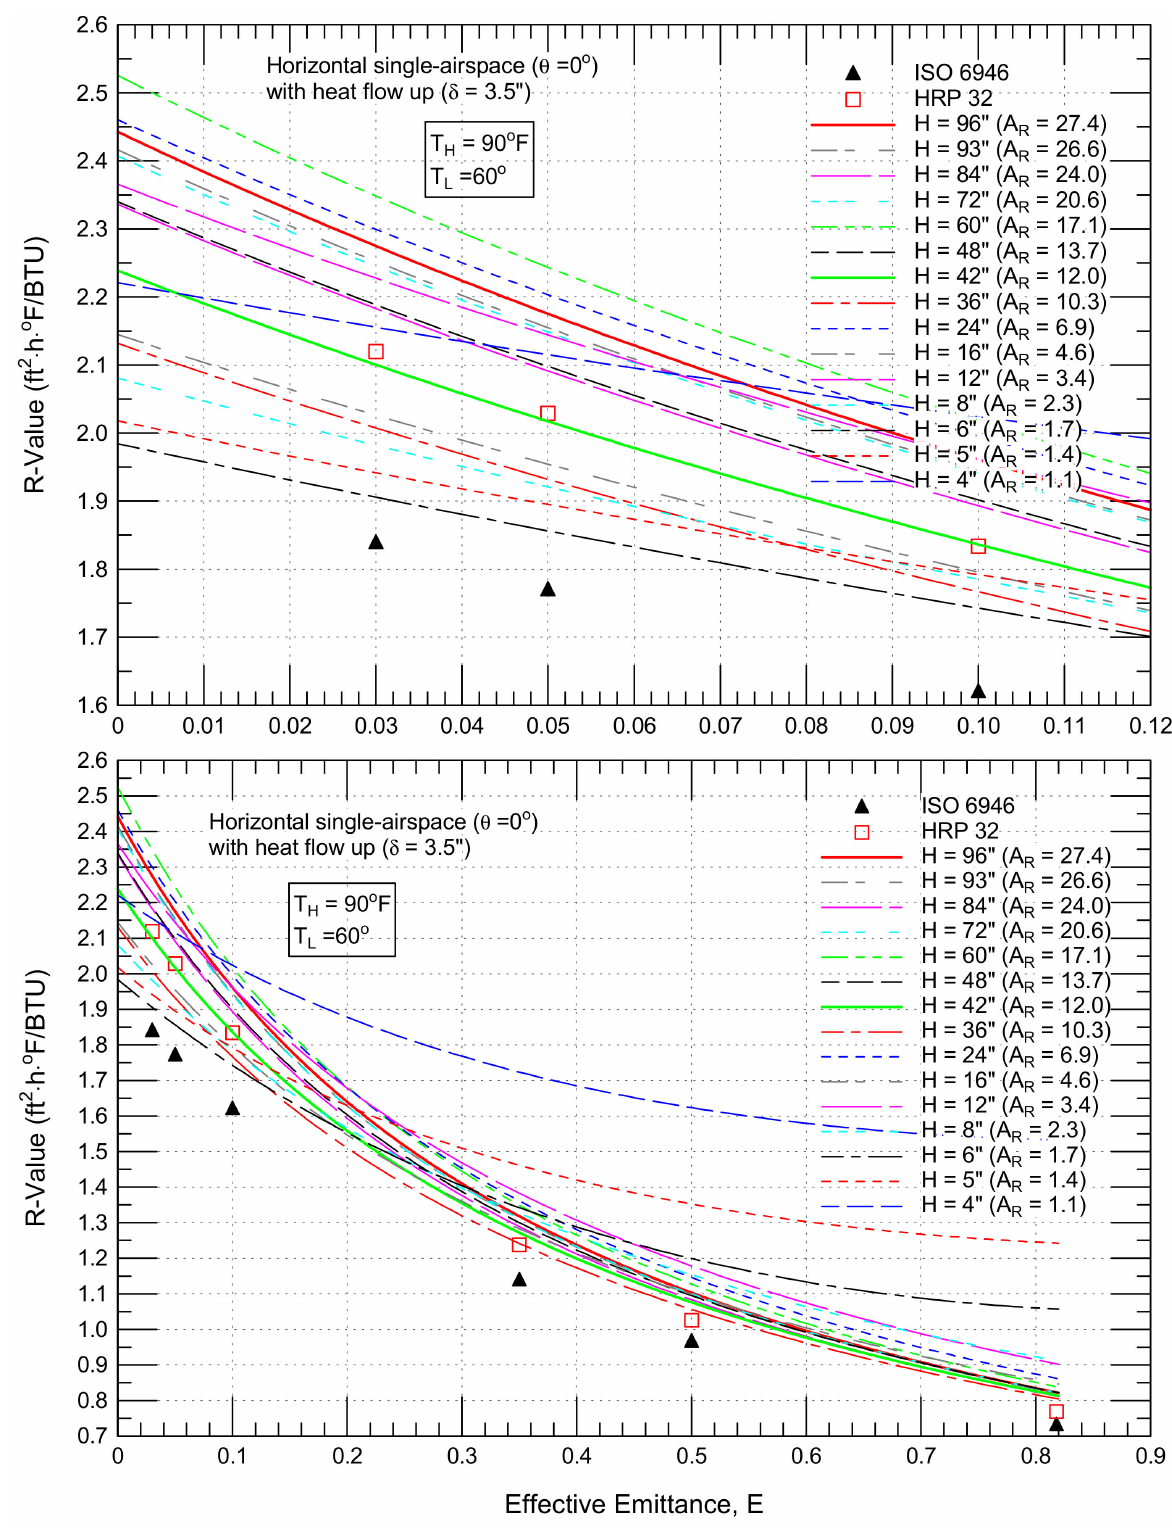
Figure 14. Comparisons of R values of HRP 32 [4], ISO 6946 [9] with present model predictions of various A R for a single airspace subjected to an upward heat flow ( θ = 0 ◦ , total δ = 3.5 inches, T H = 90 ◦ F, T L = 60 ◦